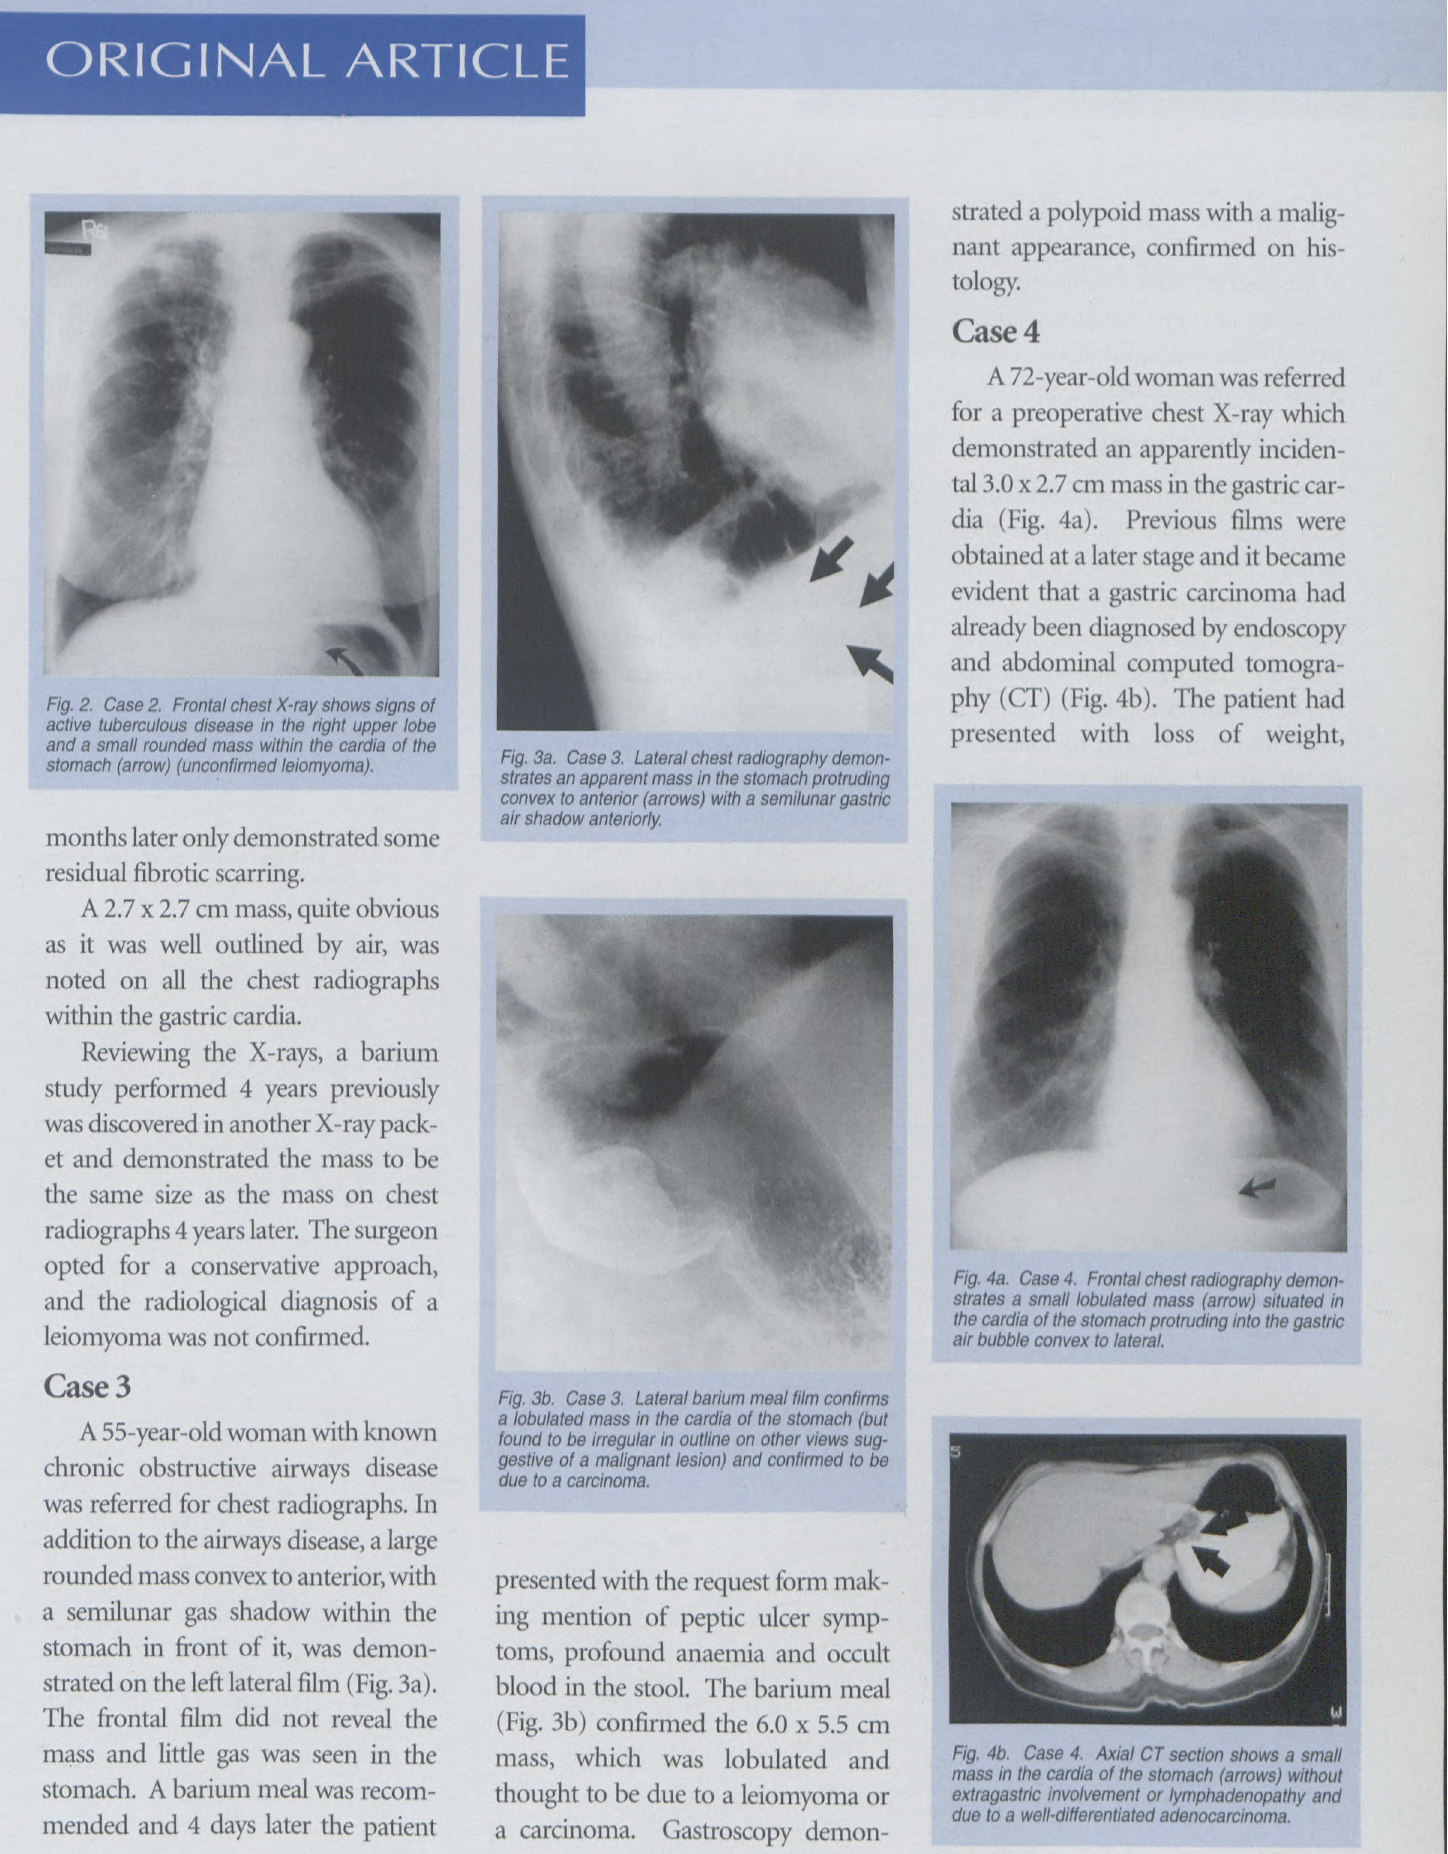
Fig. 4b. Case 4. Axial CT section shows a small mass in the cardia of the stomach (arrows) without extragastric involvement or lymphadenopathy and due to a well-differentiated